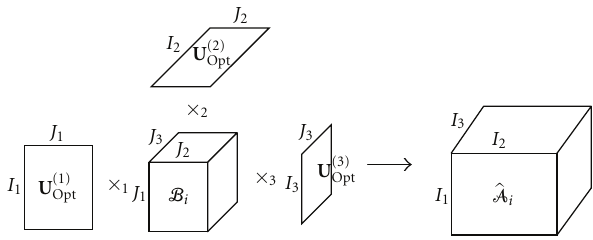
Figure 2: Reconstruction of a three-order tensor by the three orthogonal bases of mode subspace.